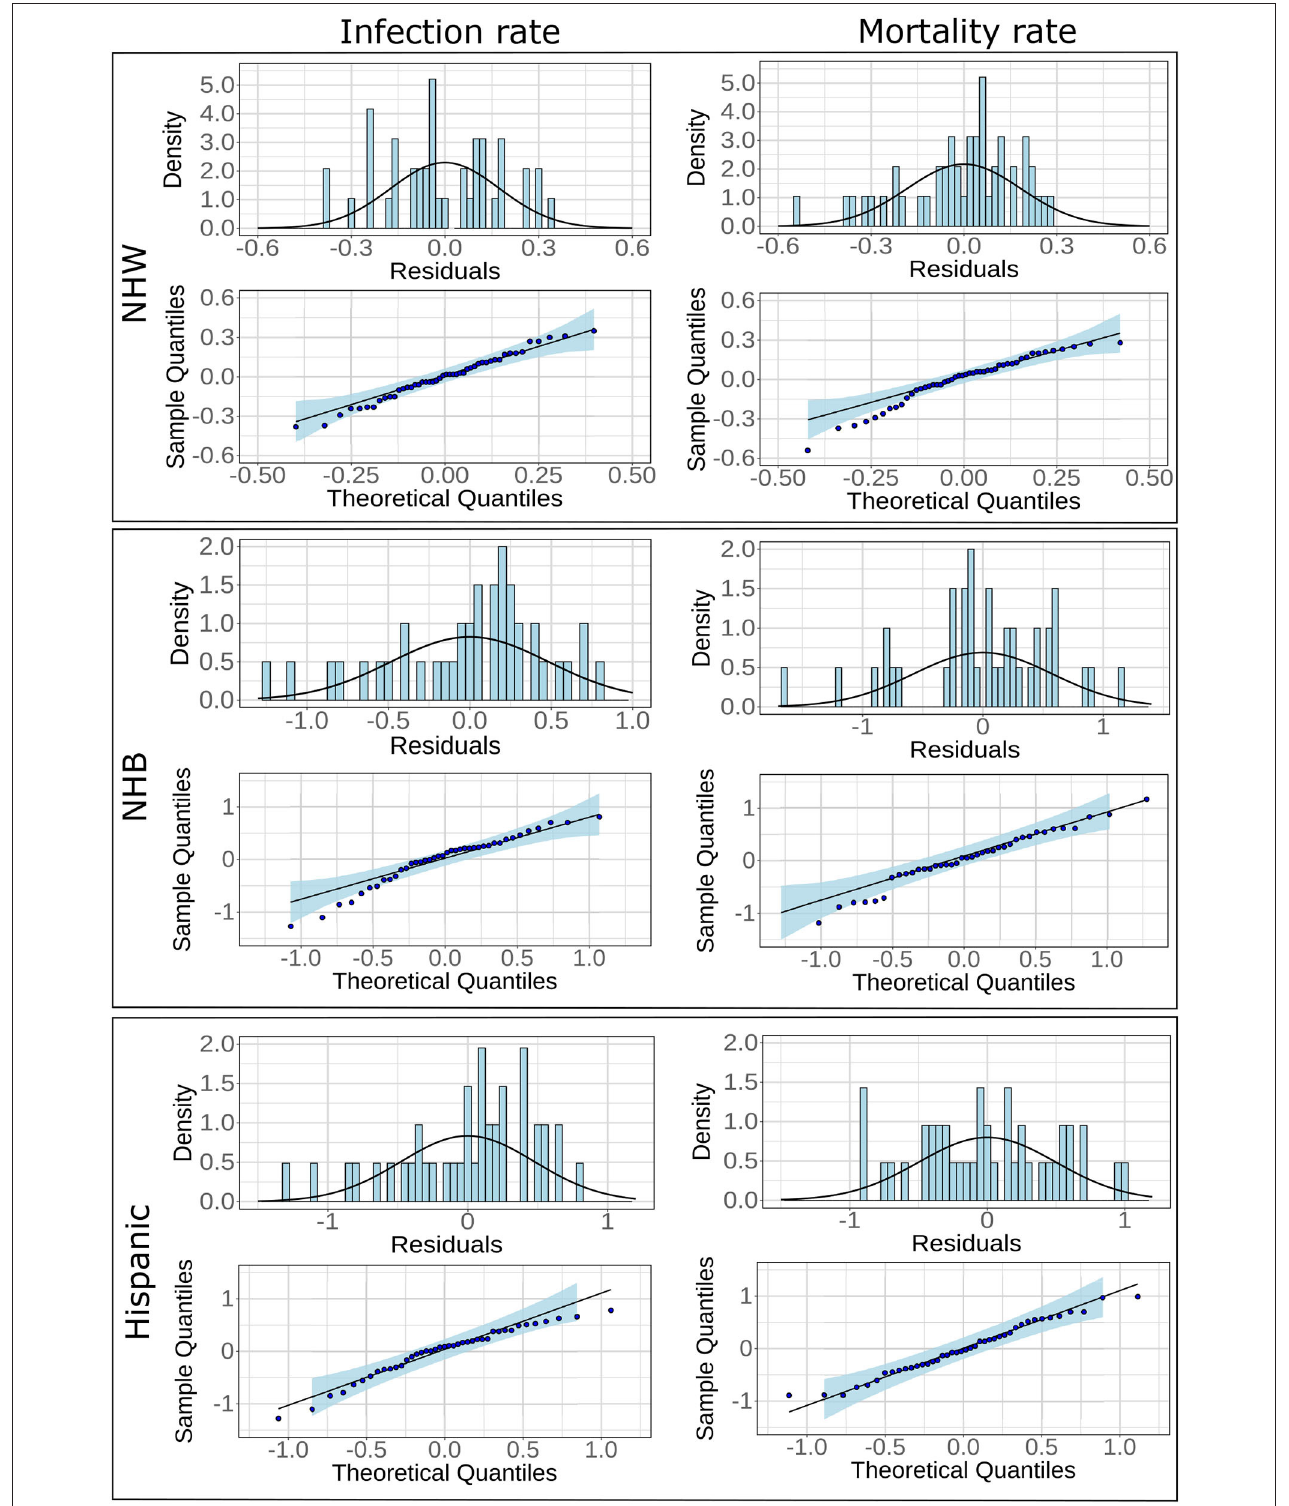
FIGURE 3 | Histograms and fitted normal curves along with QQ plots of the residuals for linear regression for NHW, NHB, and Hispanics groups. The linear models are based on infections and mortality rates as response variables.